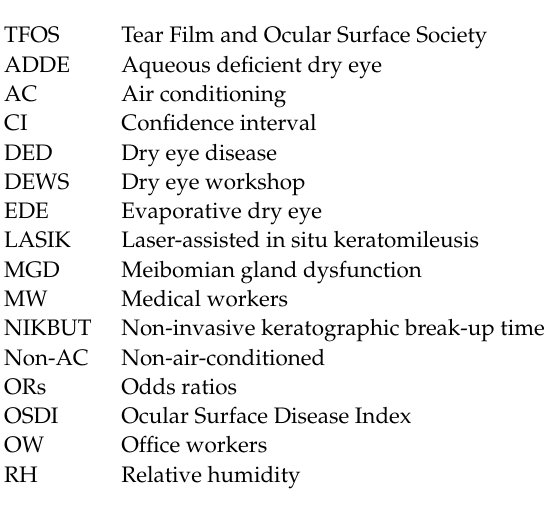
the OW and MW groups. Table S2: Measurement results of the eye surface parameters measured “before–after” work in the OW and MW groups. Table S3: Comparison of the results of the parameters of the eye surface in the OW and MW groups staying in air-conditioned rooms and rooms without conditioning. Table S4: Working time at the computer, and the results of measurements of the eye surface parameters in the OW and MW groups. Table S5: Measurement results of the eye surface parameters in the OW and MW groups after 1-year